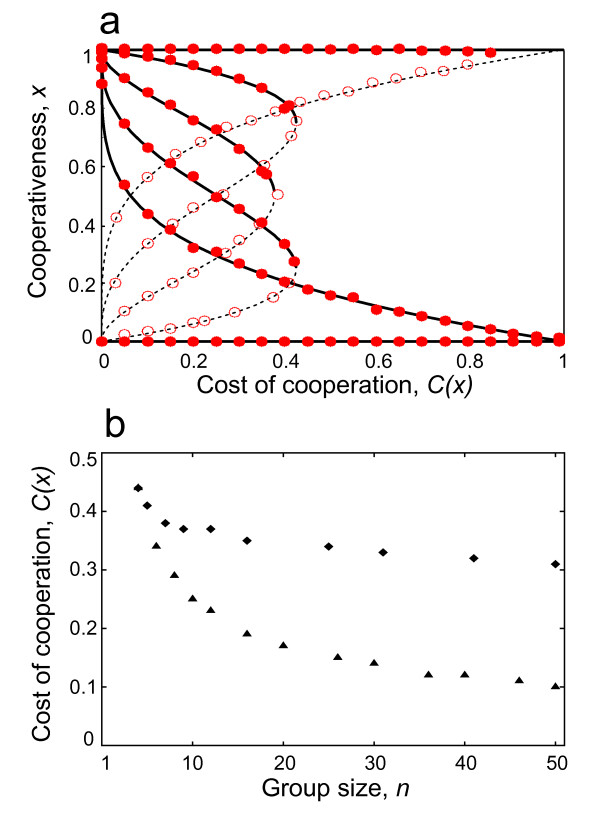
Stable and instable fix points of the model and the position of the hysteresis point for different group sizes (n). Results from numerical and individual-based (IBM) simulations show the same results. Instable fix points (dashed line for numerical simulations, open red circles for IBM simulations) separate the interior stable fix points (thick lines for numerical and filled red circles for IBM simulations) and 0 cooperativeness in the system. a, Group size (n) is 5, the threshold values are (T) 5, 4, 3, 2, 1. b, the locations of the hysteresis points (i.e. the maximal cost where cooperation still can be a stable), with different group sizes (n). (♦: T = n-1; ▲: T = n/2).